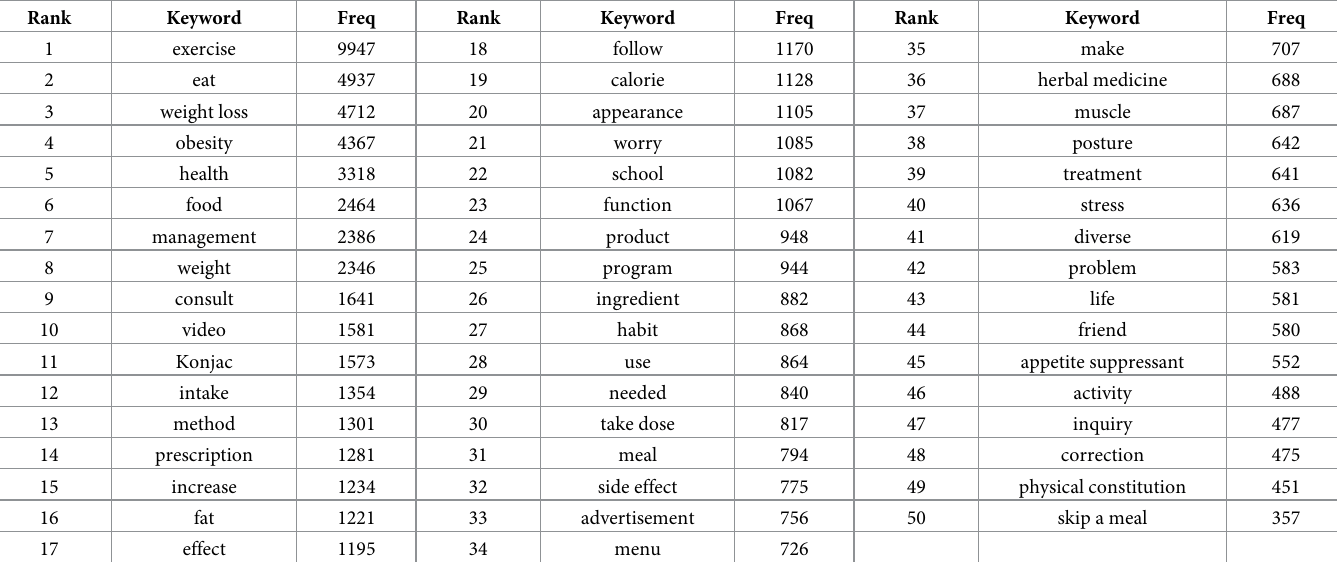
Table 2. Frequencies of 50 keywords related to adolescents’ diets in